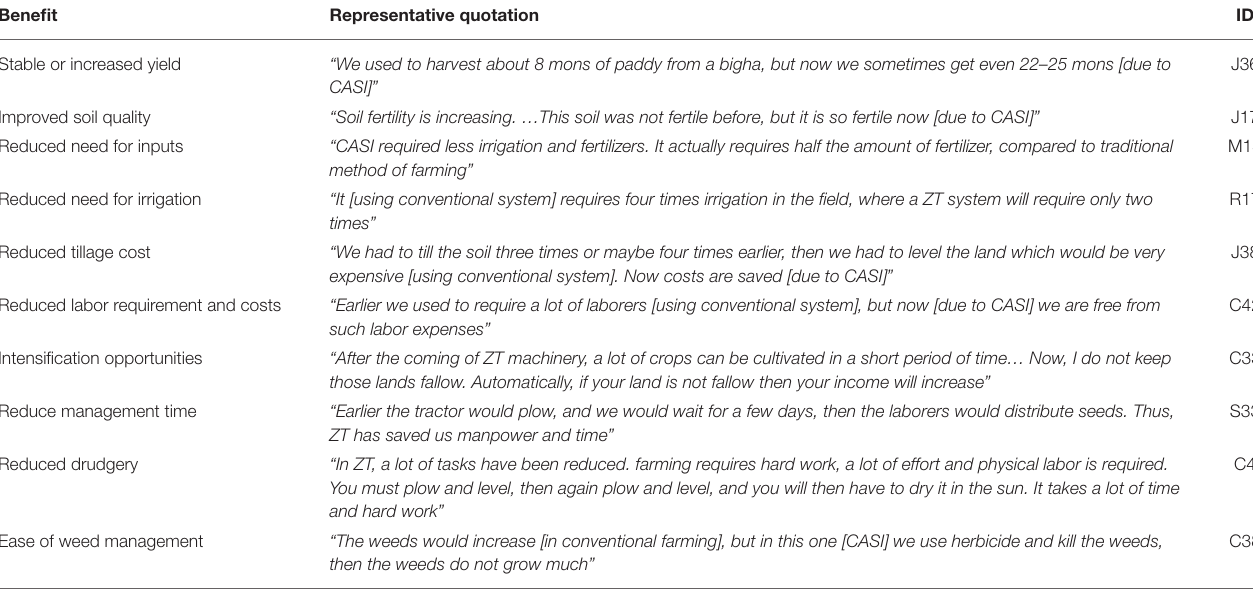
TABLE 1 | The experienced benefits of Conservation Agriculture-based Sustainable Intensification (CASI) as articulated by respondents.